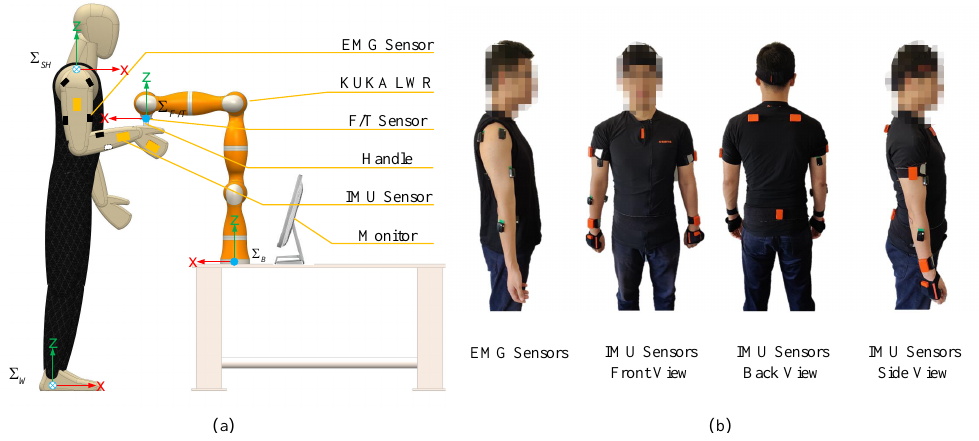
Figure 3. ( a ) The experiment setup for human arm endpoint stiffness identification. A fixed-base KUKA light-weight robot, equipped with a six-axis force/torque sensor at the end-effector, was used to apply perturbations to the human hand (note that arm endpoint movements were measured by high resolution encoders of the KUKA robot, which was active in position control mode). ( b ) EMG and IMU sensor setup. Sux EMG sensors were attached to the corresponding muscles’ places on the right arm and 11 IMU sensors were placed for upper body movement recording according to MVN Biomech suit